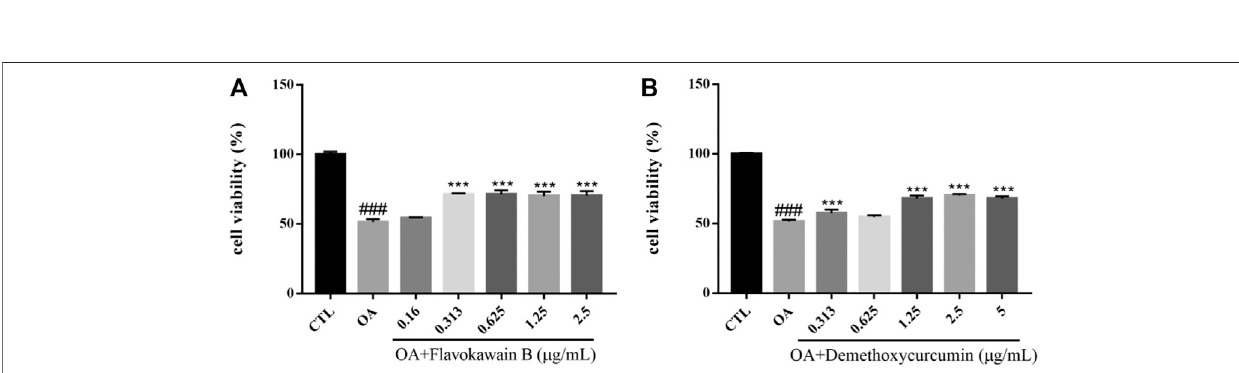
FIGURE9| VariousconstituentssuppressedA β -inducedcytotoxicityinSH-SY5Ycells.CellswerepretreatedwithdifferentconcentrationsofNonivamide (A) ,3,4- Dimethoxycinnamic acid (B) or 0.1% DMSO for 2 h and then incubated with or without A β 1 – 42 (10 μ M) for 24 h and the cell viability wasdetected byMTT assay. Results areshownasthemean ± SEMandrepresentthreeindependentexperiments.### p < 0.001comparedwithcontrolgroup,*** p < 0.001comparedwithA β treatedgroup.